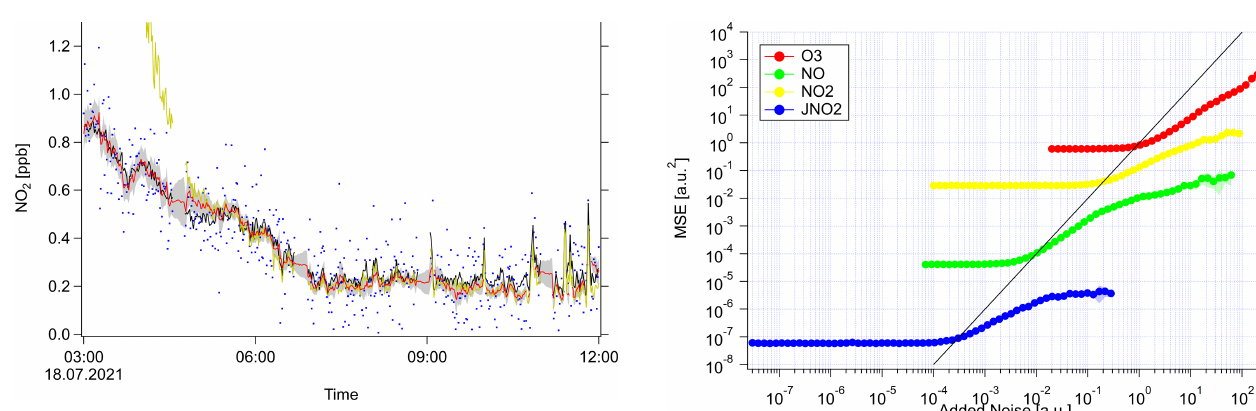
Figure 5. MSE of the SMC estimation as a function of artificial noise to study the precision enhancement abilities. The MSE units are represented by lines and markers and the standard deviation by the shaded region for the ensemble of repetitions. The plot shows the results of all variables: ozone (red), NO (green), NO 2 (yellow) and j NO (blue). Note that the units of MSE and artificial noise are 2 arbitrary to display all variables in one plot. The unit of the noise is ppbv for the trace gases and inverse seconds (s − 1 ) for the photolysis frequency. The unit of MSE is the square, respectively. The solid black line indicates the baseline MSE (MSE = noise 2